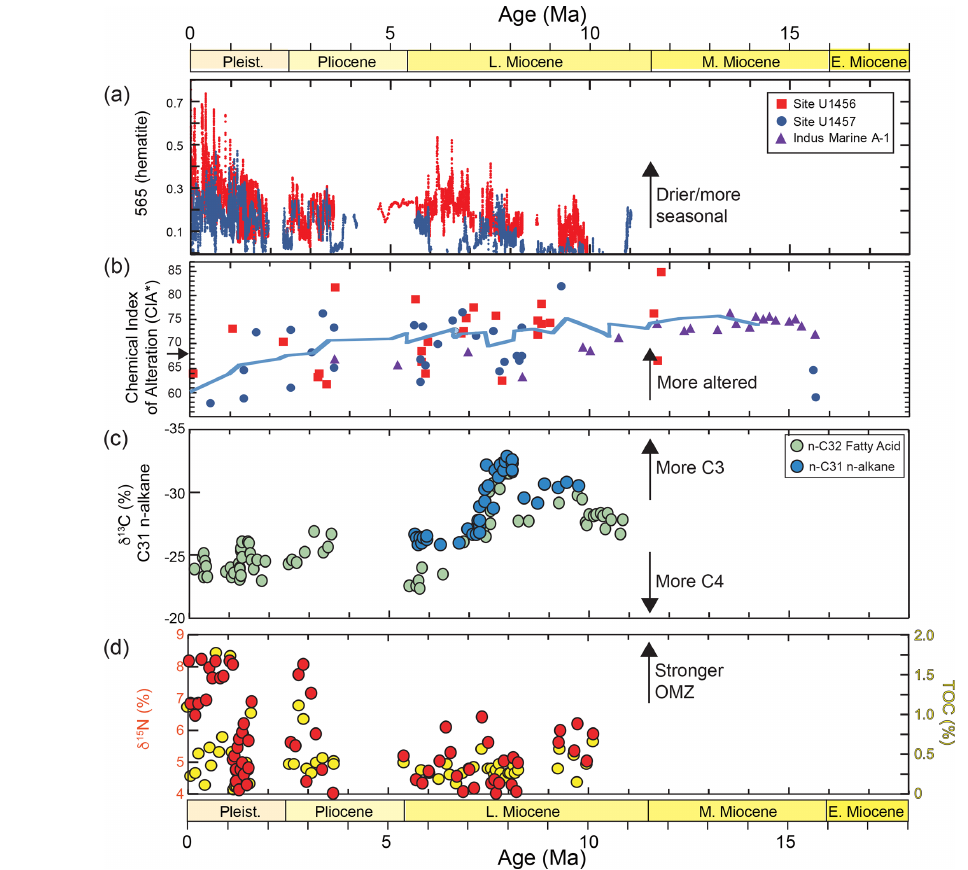
Figure 2. Temporal evolution in weathering proxies from the Laxmi Basin together with possible forcing factors. (a) 565 spectra intensity (hematite) and (b) CIA*, from Zhou et al. (2021), (c) δ 13 C of n -C 32 fatty acids (Suzuki et al., 2020) and from n -C 31 n -alkanes (Feakins et al., 2020), and (d) δ 15 N and total organic carbon (TOC) from Tripathi et al.